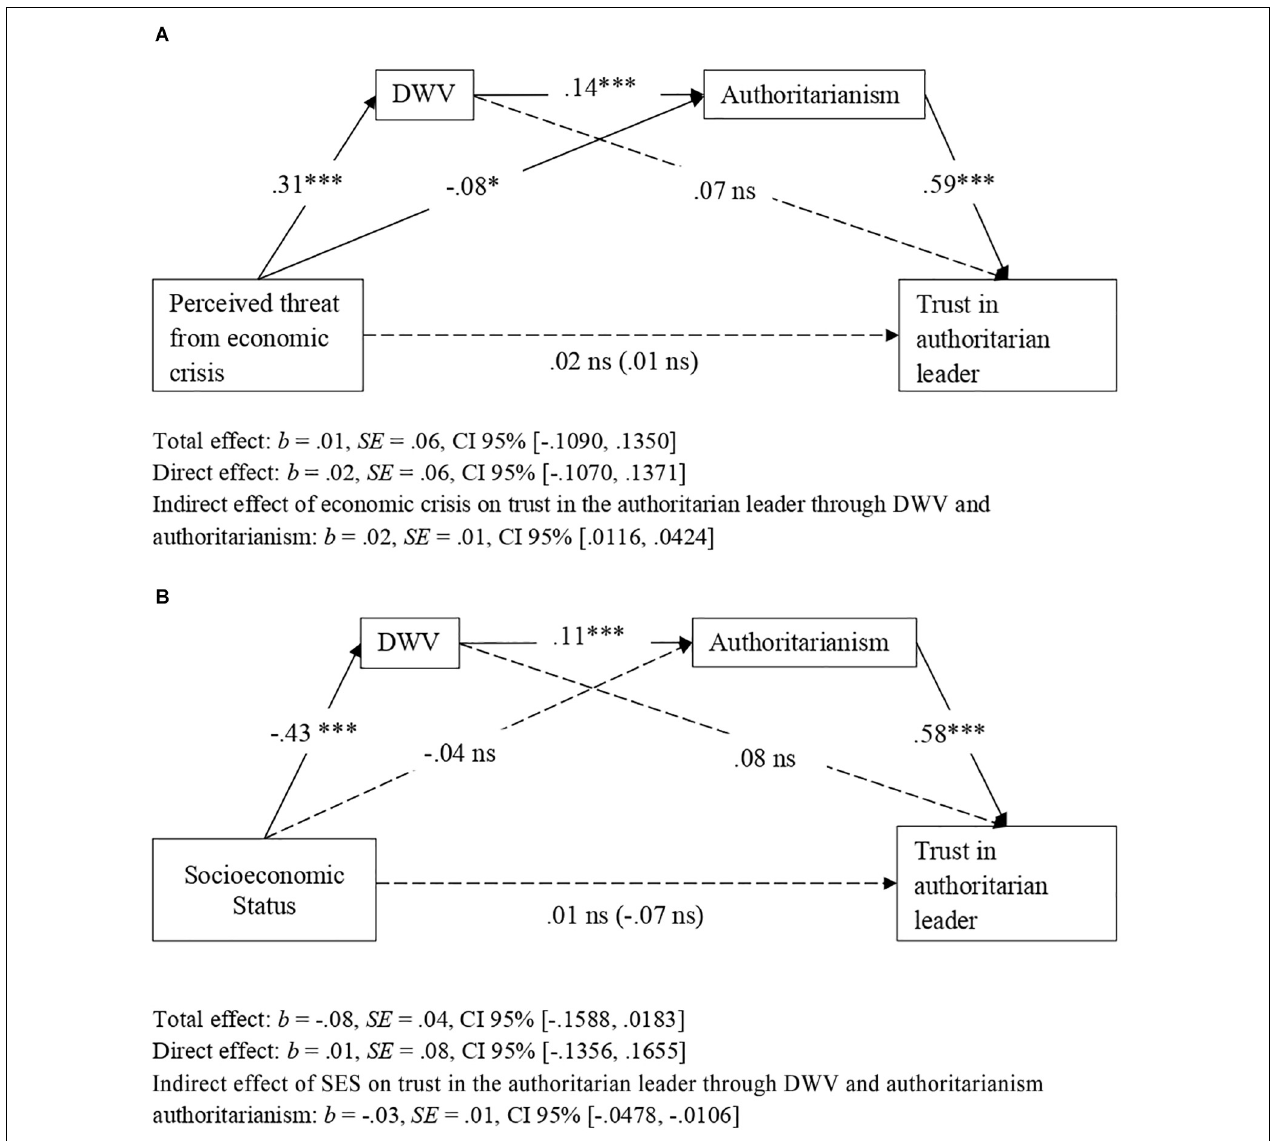
FIGURE 3 | Indirect effects of perceived threat form economic crisis (A) and SES (B) on trust in an authoritarian political leader via dangerous worldview (DWV) and authoritarianism (Study 2). Figure shows the effects without consideration of covariates. Non-significant effects appear with dashed lines. Unstandardized coefficients presented. * p < 0.05, *** p <